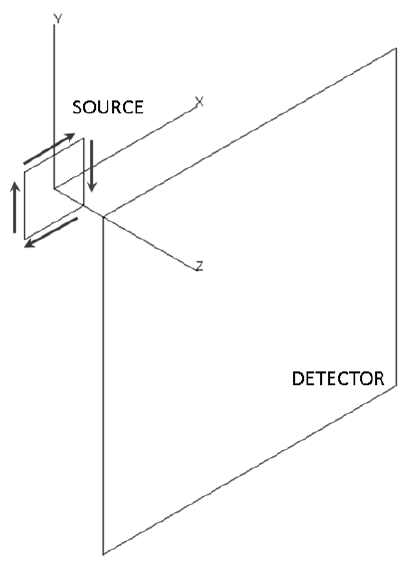
Figure 1. Sketch of the 3D analyzed system of non-symmetric source.